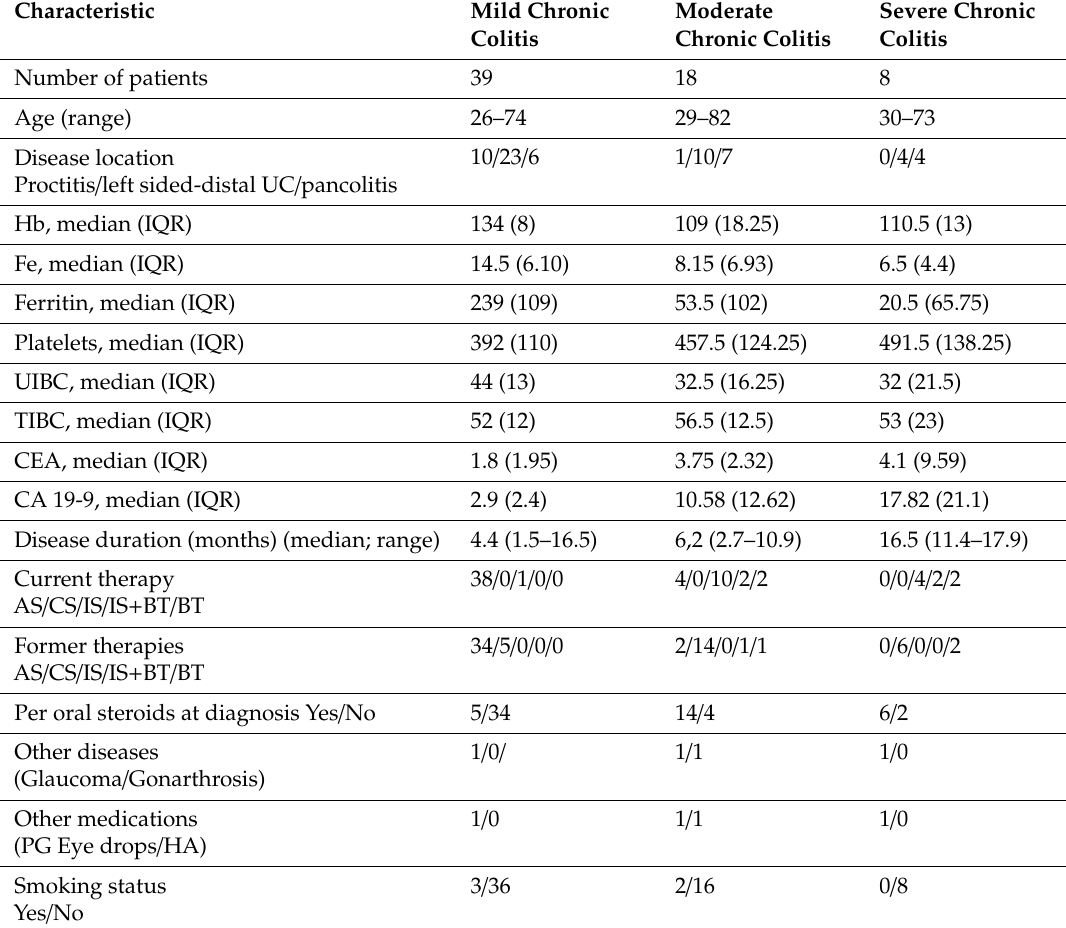
Table 1. Demographic and clinical characteristics of UC